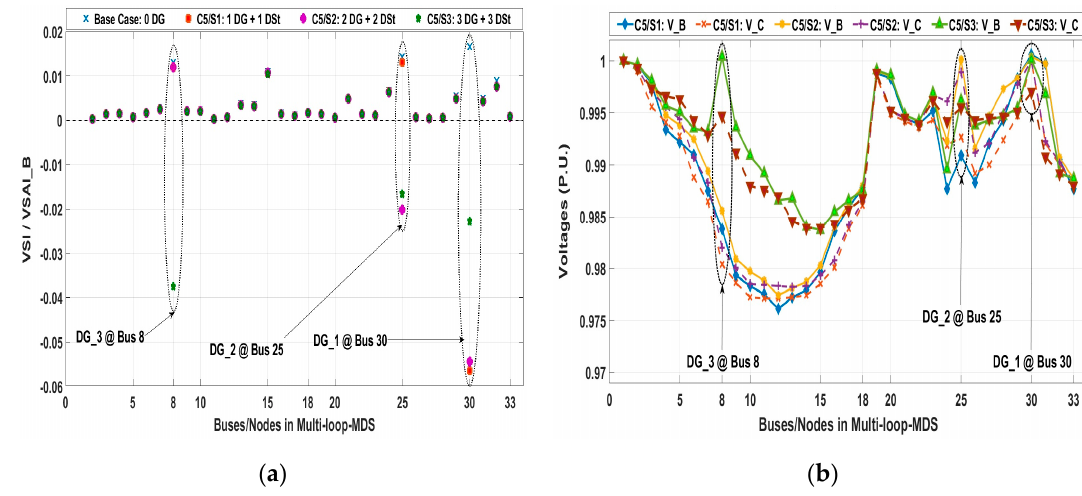
Figure 10. Case 5 for 33-bus MDS: DG (type-1) and DSTATCOM (type-3) equivalent to 0.85 ± 3% PF ( a ) VSAI_B trend, ( b ) V_B profile trend as feasible solution of VSAI_B and calculated V_C profiles. The comparative voltage difference across tie-line branches for case 5 is indicated in terms of V_B (highlighted) and V_C values in (P.U).